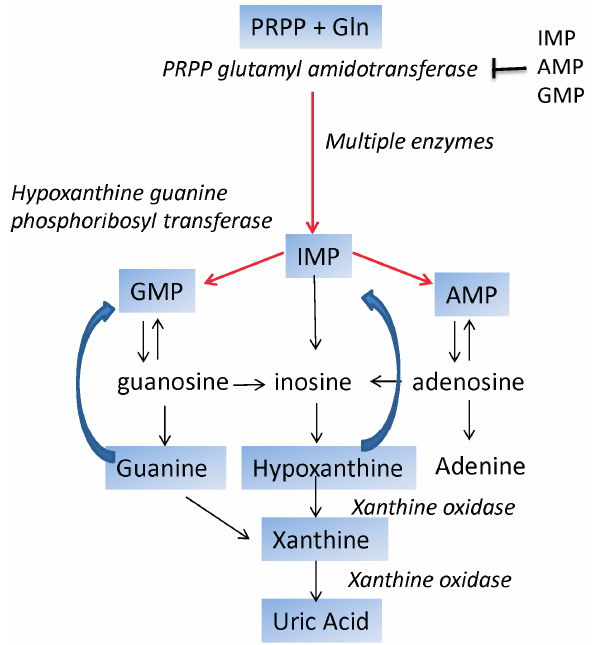
Figure 1. Outline of purine de novo synthesis, salvage, and degradation. Red arrows indicate sysnthesis, and blue arrows indicate salvage. Black arrows indicate the conversion of nucleotides to nucleosides and bases, and the conversion of nucleosides to nucleotides. Phosphoribosyl pyrophosphate (PRPP) is inhibited by adenylate (AMP), inosylate (IMP), and guanylate (GMP), as